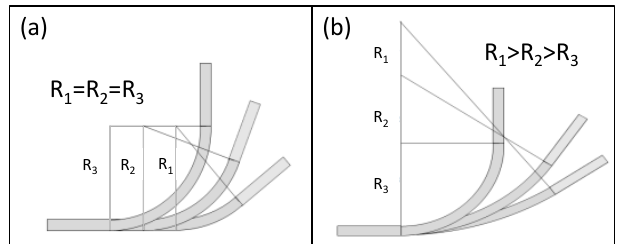
Figure 12. ( a ) Constant bending radii in each roll pass, and ( b ) constant bending arc length in each roll pass .